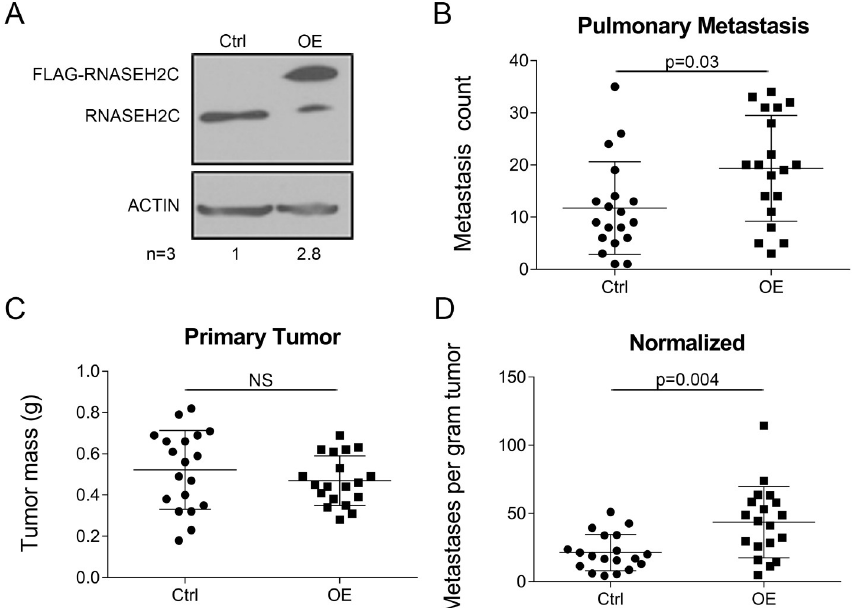
Fig 2. Overexpression of Rnaseh2c increases pulmonary metastasis. (A) RNASEH2C protein expression by western blot following exogenous overexpression (OE). One representative blot is shown, average relative densitometry for three independent experiments is reported below; OE lane is combined endogenous and exogenous tagged RNASEH2C expression. (B-D) OE cell line was orthotopically injected along with empty vector control (Ctrl) as described. Pulmonary metastases (B) and tumor mass (C) were quantified at euthanasia and normalized (metastases per gram of tumor, D); average ± standard deviation, n = 19 mice per group in two independent experiments. NS—not